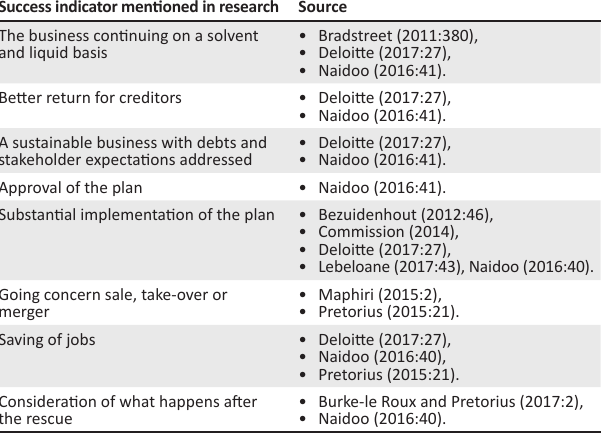
TABLE 2: Summary of local literature referring to business rescue success. Success indicator mentioned in research